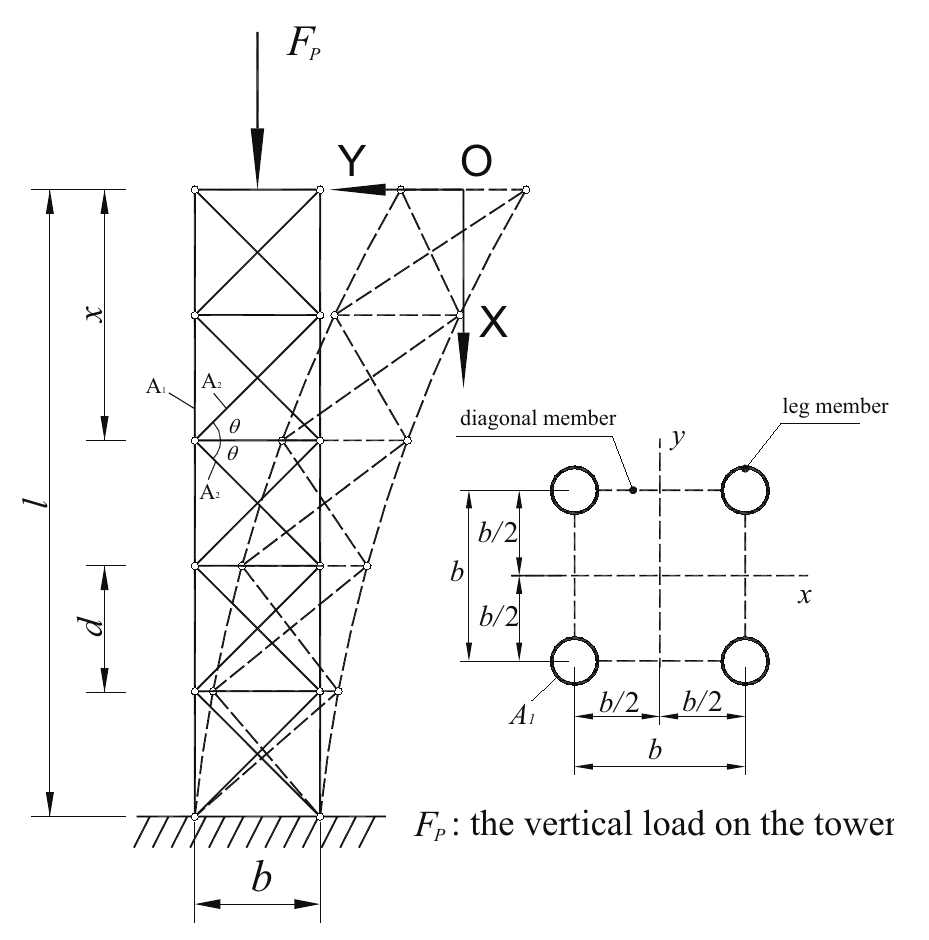
Figure 2. The quadrilateral lattice